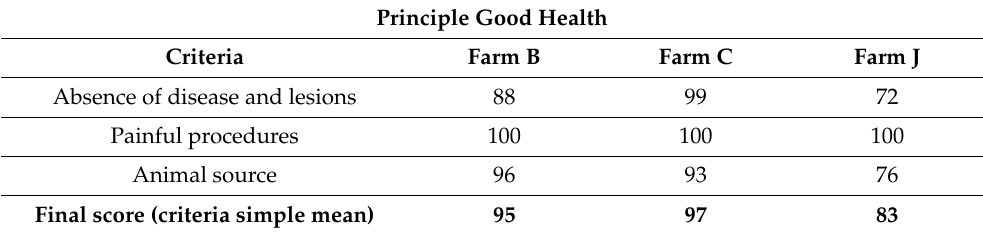
Table 8. Final score for the good health principle.